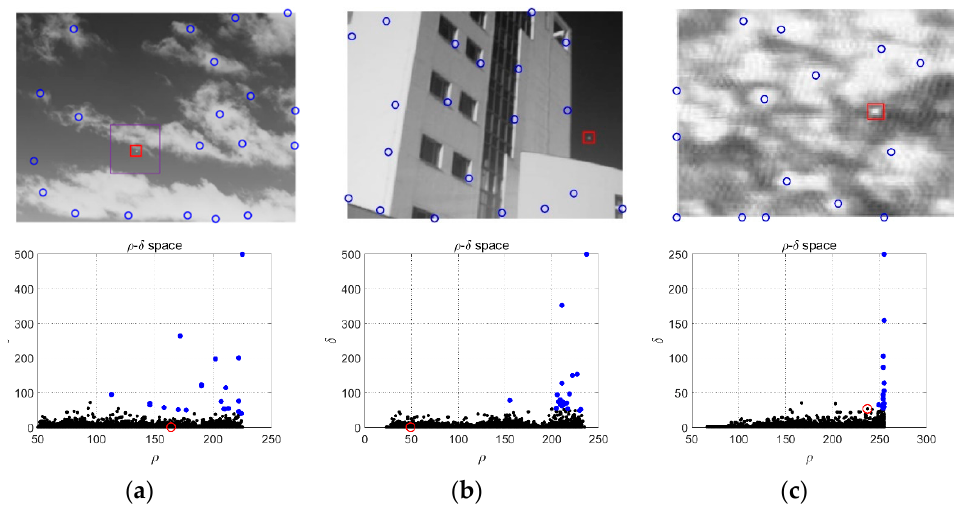
Figure 1. Some scenes where small targets are missed by the DPS. ( a ) The target is close to the clouds; ( b ) There are buildings near the target; ( c )The target is on the sunlit lake. The first row shows candidate targets extracted by DPS, blue circles mark density peaks, and red boxes mark targets that are missed in the image. The second row shows the ρ – δ feature space of each image, with density peaks represented by blue dots and target points marked by red circles.